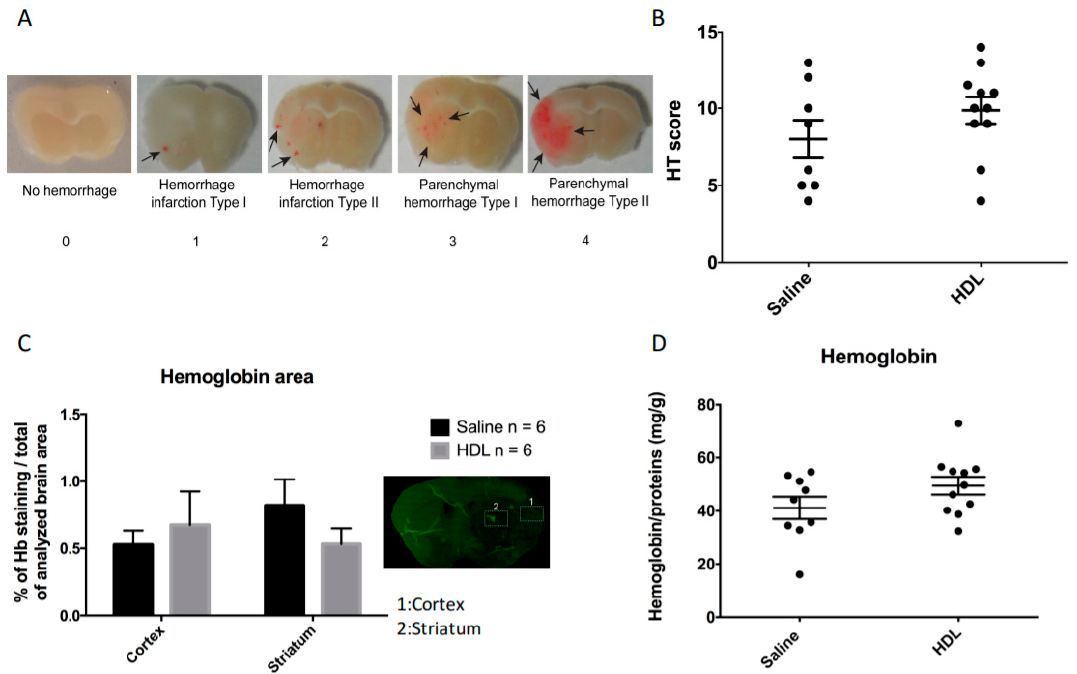
Figure 3. Hemorrhagic transformation (HT) and hemoglobin quantification. ( A ) Representative brain slice pictures allowing